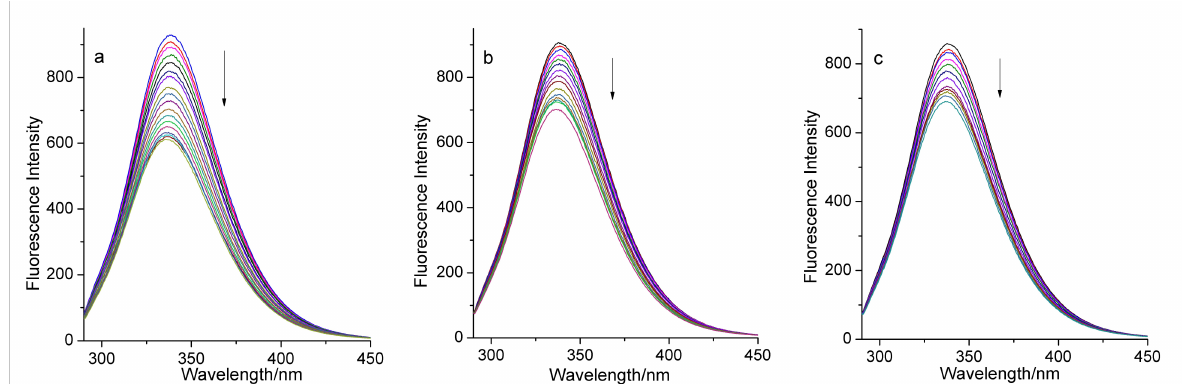
Figure 3. The quenching effect of complex 1 on BSA fluorescence at 298 K ( a ), 308 K ( b ), and 313 K ( c ). The arrows show the emission intensity changes upon the increasing concentrations of complex 1 .